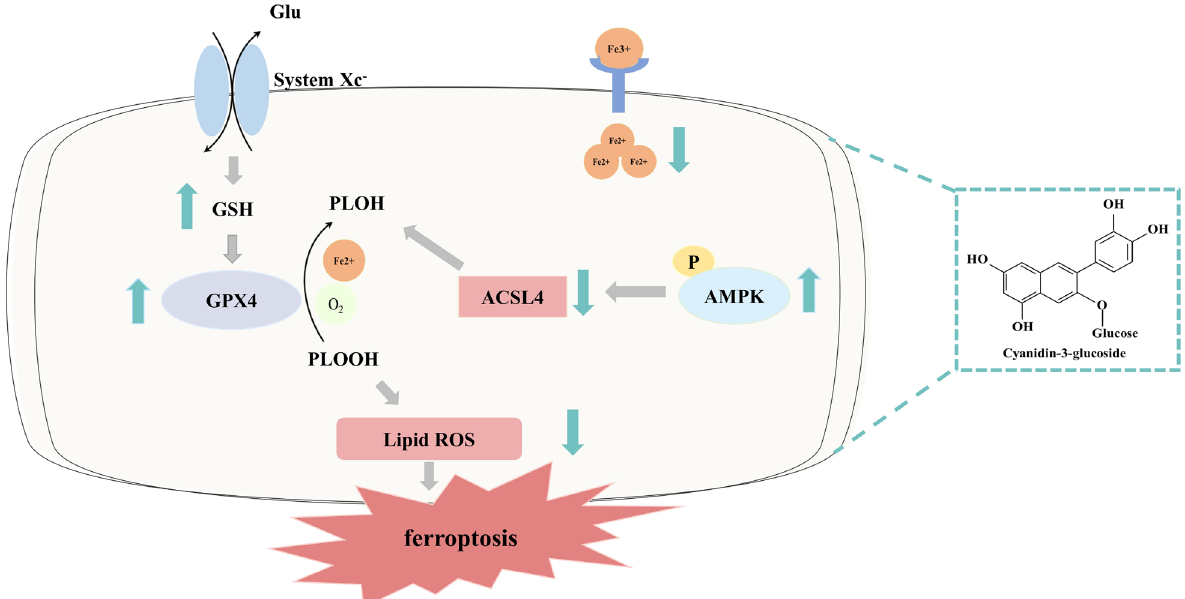
Fig. 8 A proposed scheme demonstrating the protective effect of C3G against AKI. C3G decreased free iron accumulation and lipid peroxidation products, increased the levels of GSH and the expression of GPX4 and downregulated the expression of ACSL4 to inhibit ferroptosis in the renal tubular epithelial cells during AKI, which is dependent on the activation of